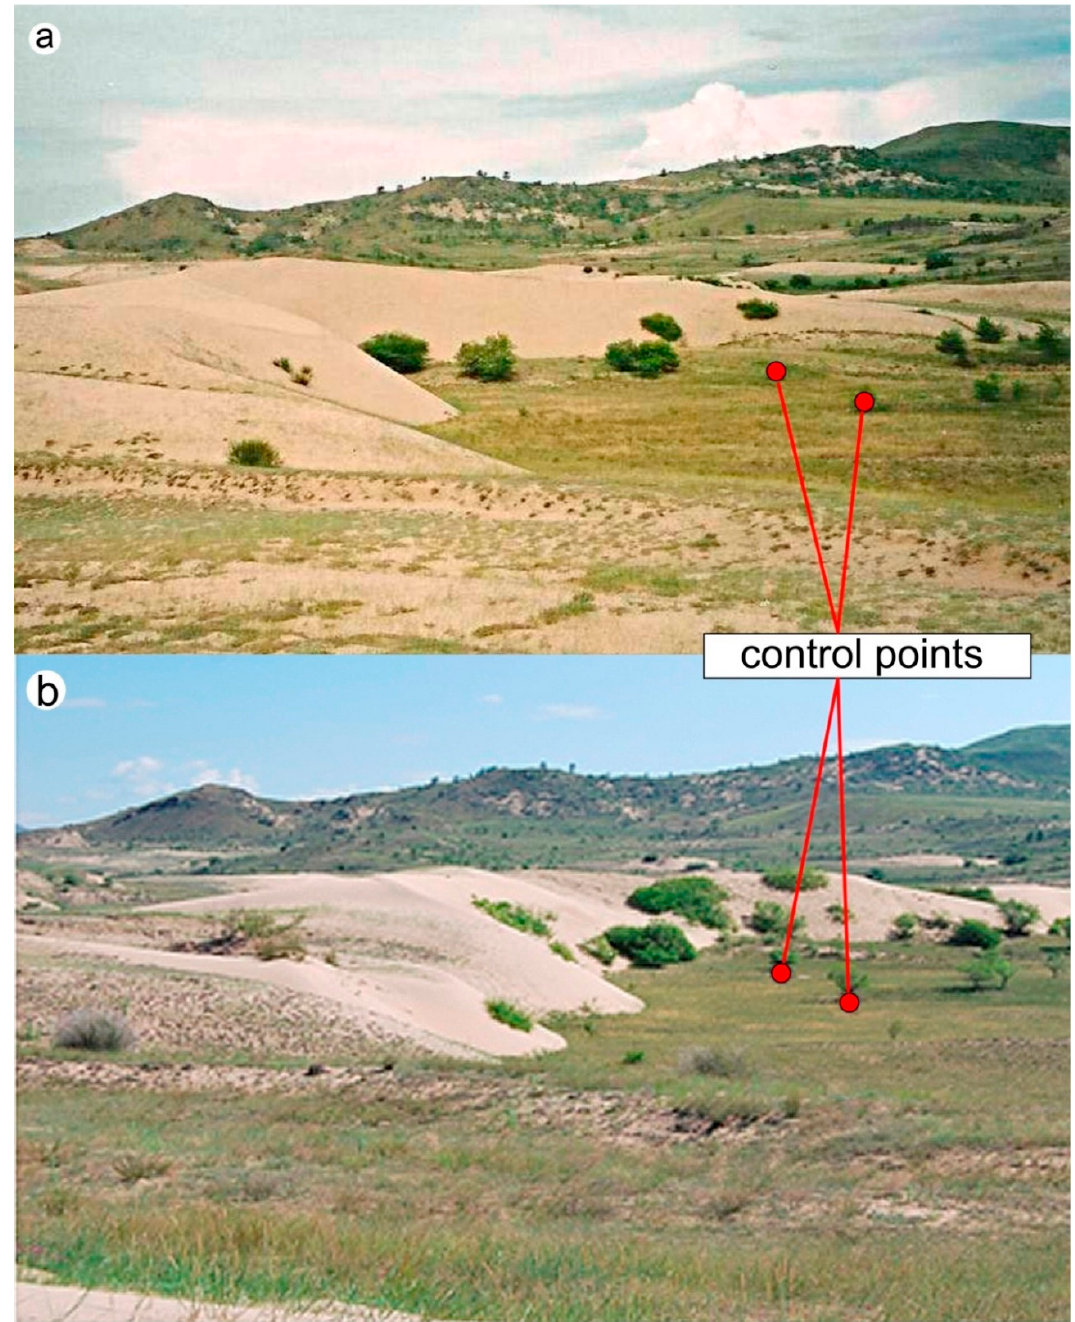
Figure 8. Dynamics of dune field chain in the Nomokhonovo stow in the valley of the Selenga river for the period from 2000 ( a —photo by T. Shchipek) to 2013 ( b —photo by D. Kobylkin).